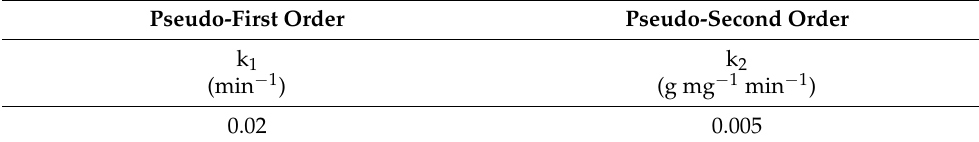
Table 1. Parameters of kinetic modeling for Cr(VI) elimination by rice husk.